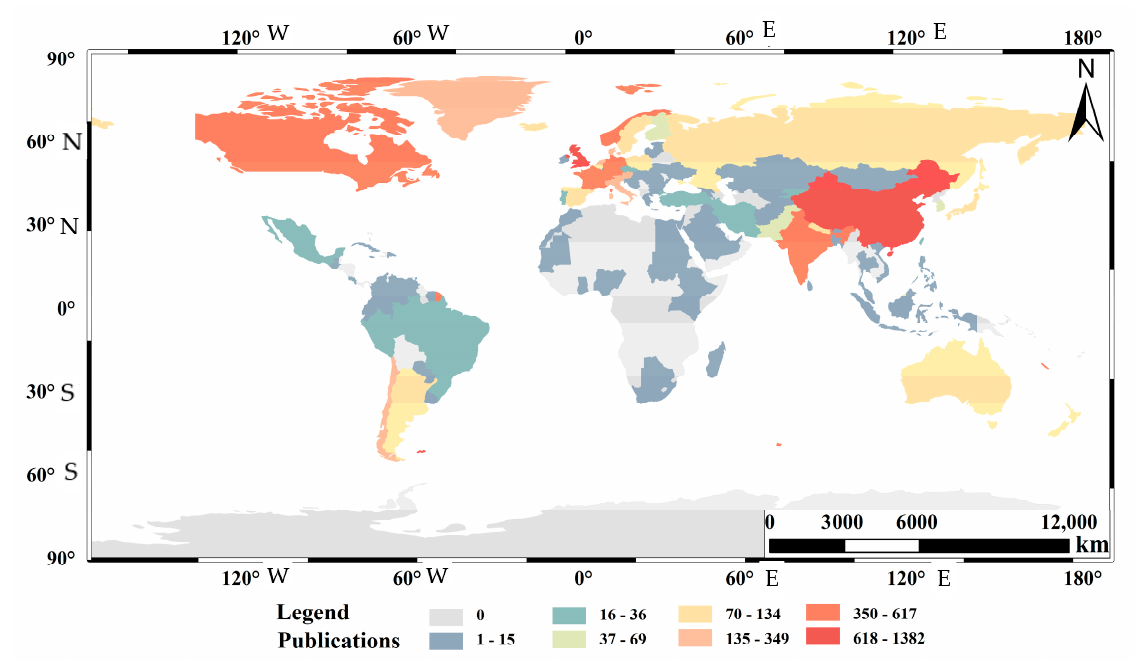
Figure 5. Number of publications in different countries or regions.